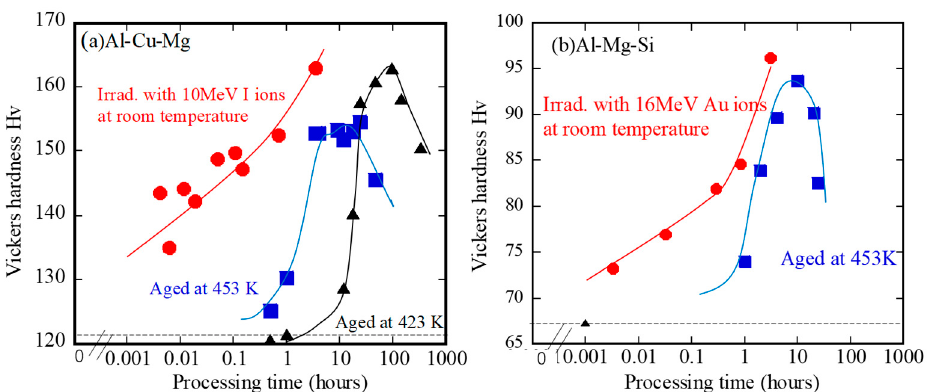
Figure 10. Comparison of the change in Vickers hardness between irradiated specimens and thermally aged specimens as a function of processing time, ( a ) Al-Cu-Mg alloy and ( b ) Al-Mg-Si alloy. Dashed lines show the values of hardness before irradiation or thermal aging.